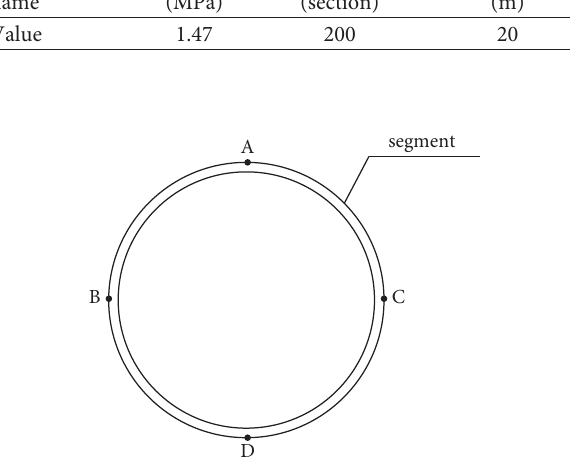
Figure 5: Layout of monitoring points. Table 5: Parameters of segment and grouting